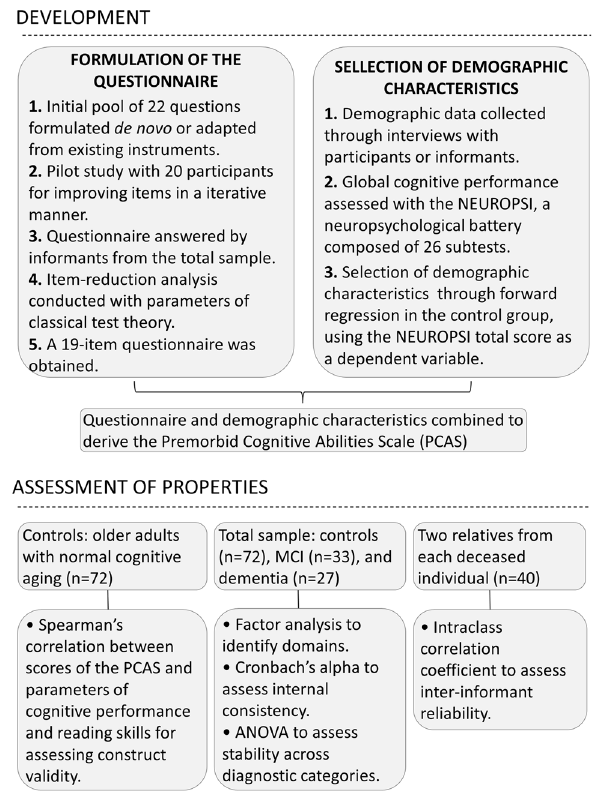
Figure 2. Flowchart depicting the steps involved in the development and validation of the